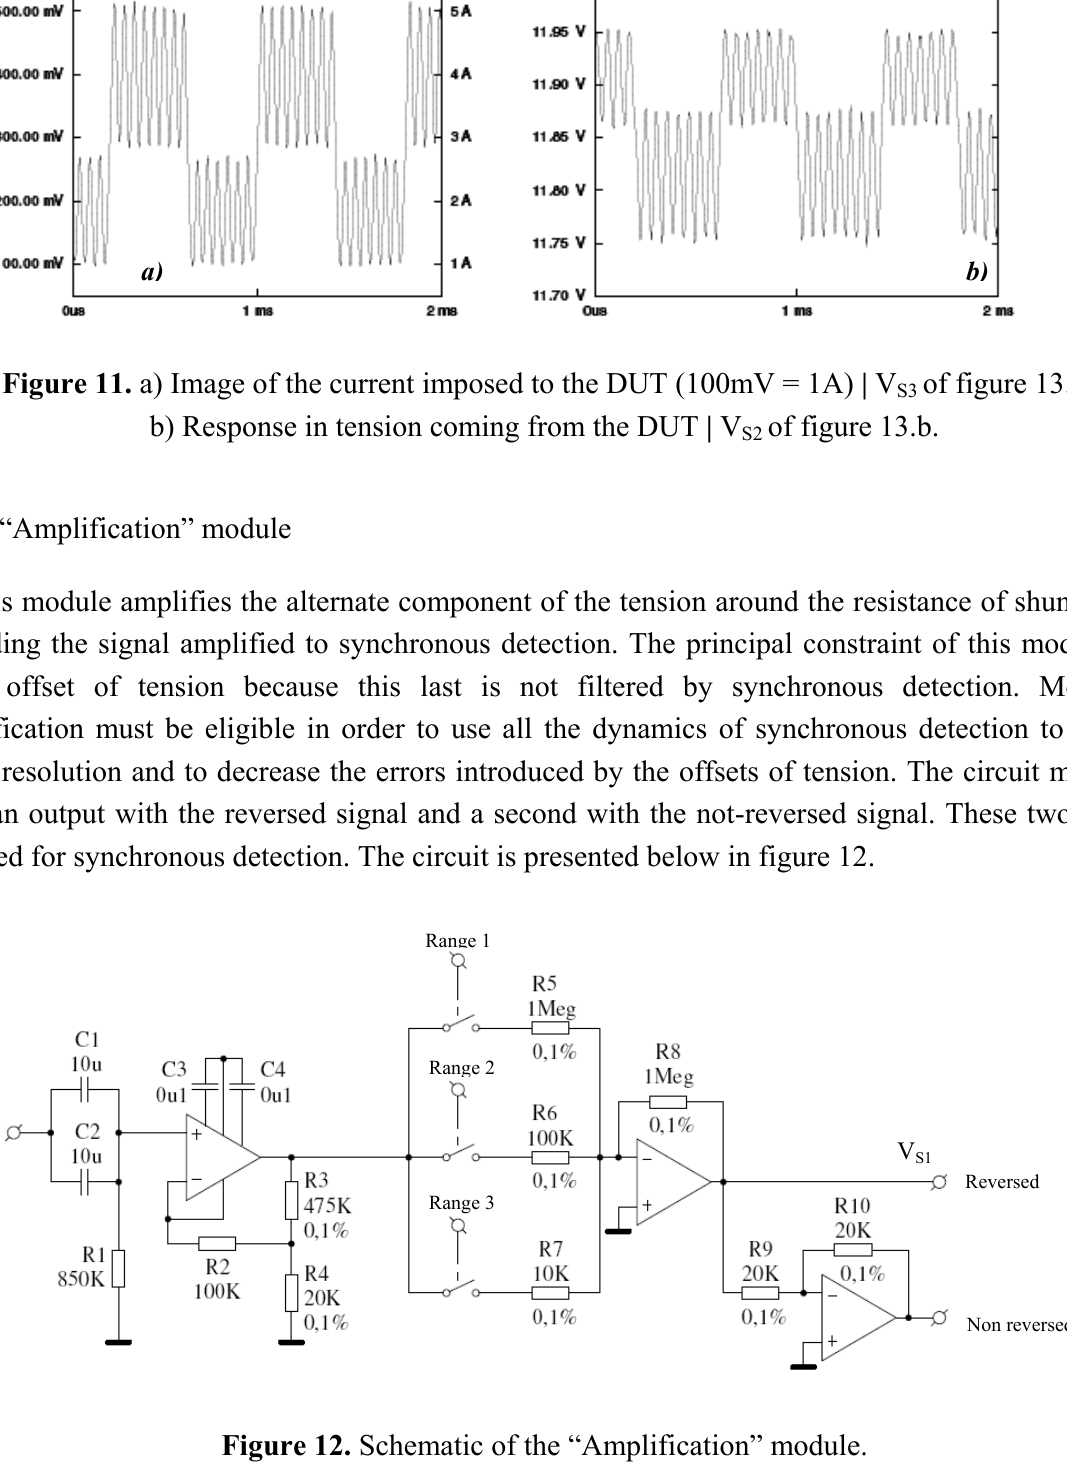
Figure 12. Schematic of the “Amplification”